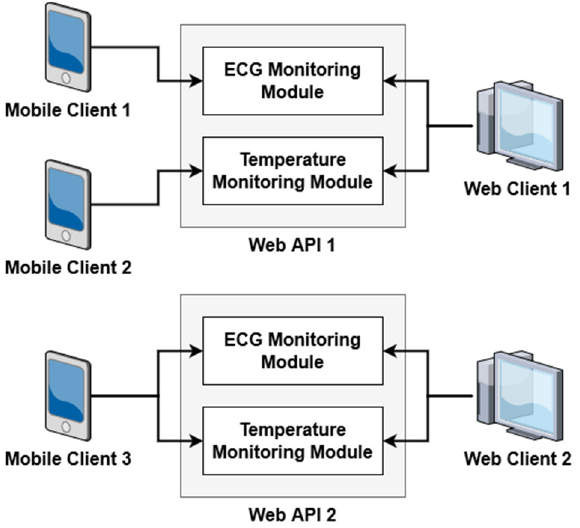
Figure 2. Overview of module system.